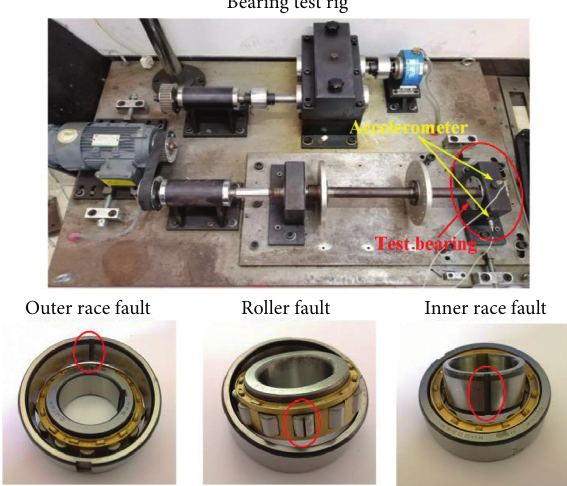
Figure 7: The bearing test rig and three kinds of bearing